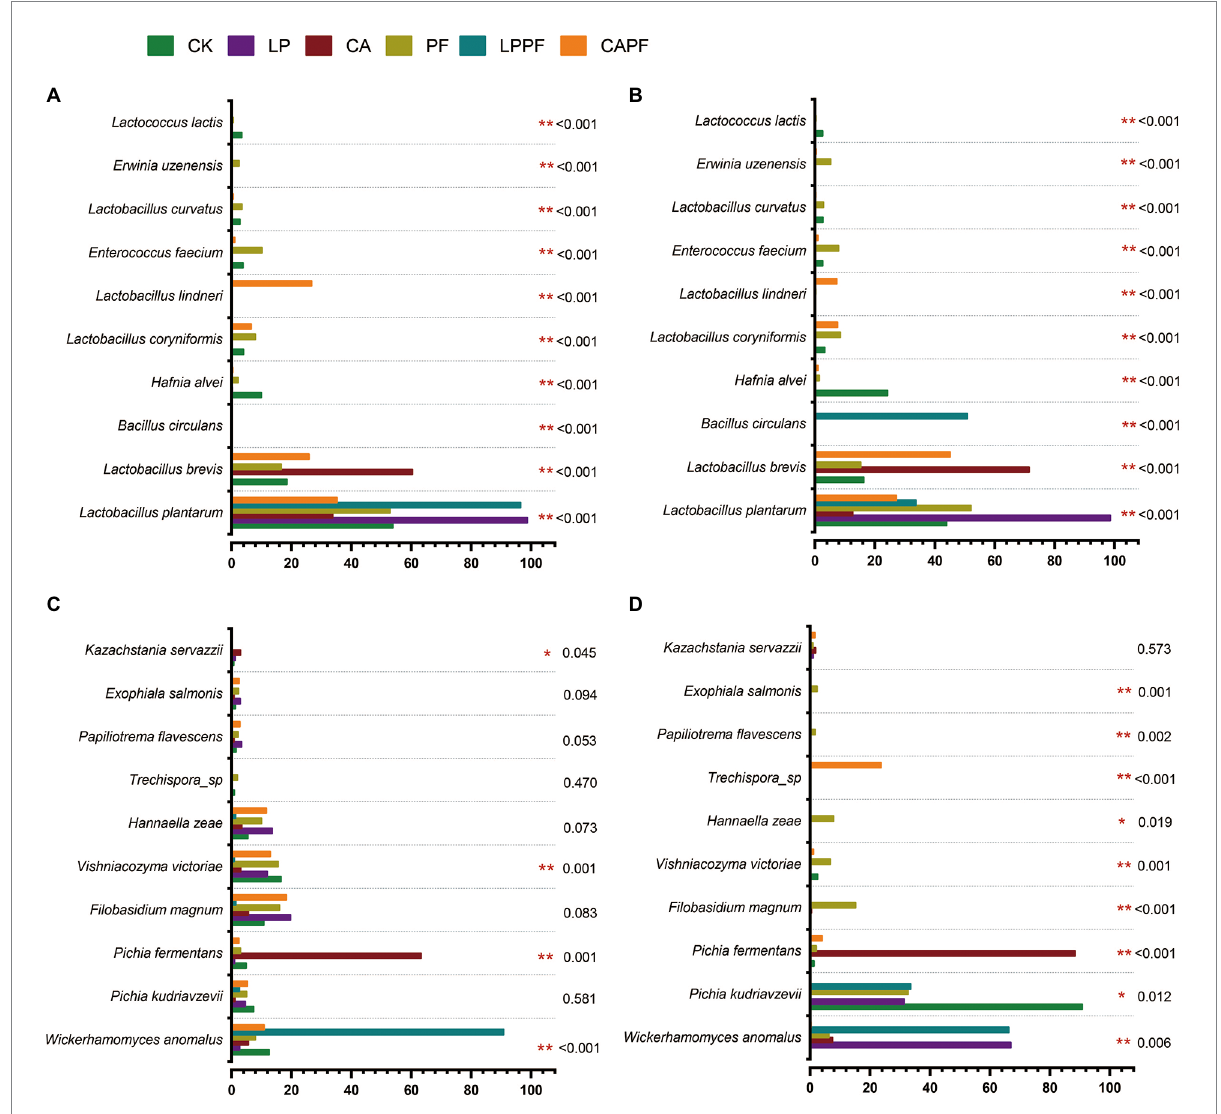
FIGURE 4 One-way analysis of variance bar plots of top 10 species of bacterial and fungal in forage oat silages. Bacteria species level on 60-day of ensiling (A) , and 3 days of aerobic exposure (B) ; fungal species level on 60-day of ensiling (C) , and 3 days of aerobic exposure (D) . * and ** represent p < 0.05 and p < 0.01, respectively. CK, control; LP, Lactobacillus plantarum a214; CA, citric acid; PF, purple perilla; LPPF, purple perilla + Lactobacillus plantarum a214; CAPF, purple perilla + citric